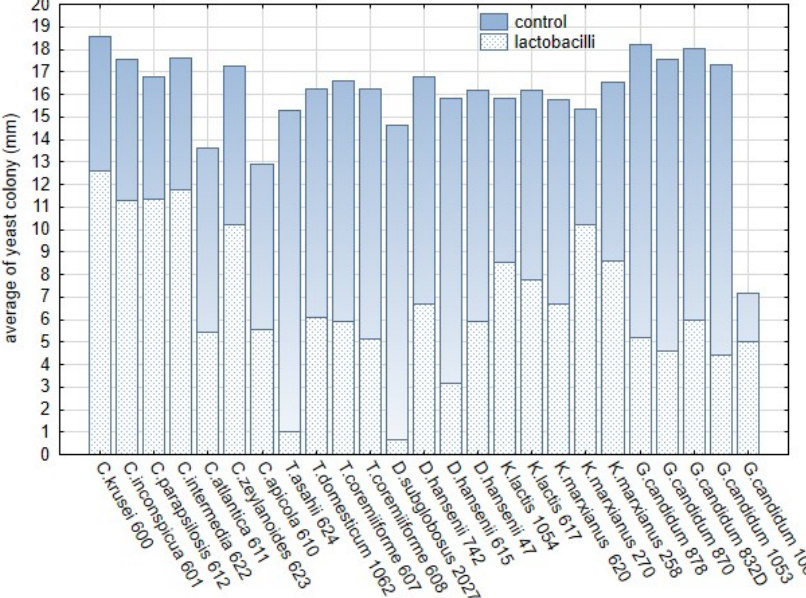
Figure 10. The comparison of the average sizes (mm) of the yeast colonies growing on malt extract agar supplemented with reconstituted milk with L. plantarum strains in and control variants without L. plantarum . The dotted bars represent the average of the yeast colony, blue part represents the control variant without lactobacilli.